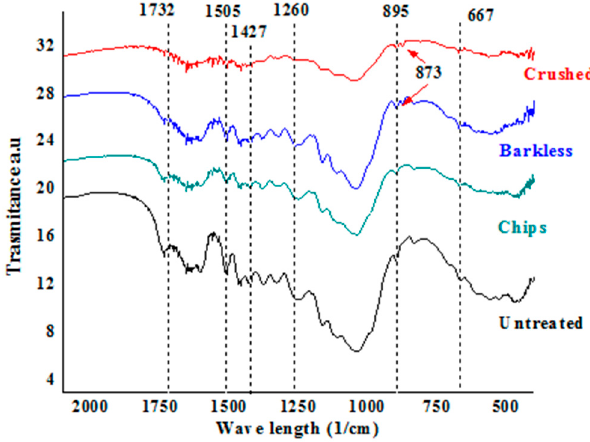
Figure 8. Fourier-transform infrared spectra in the 2100–500 cm − 1 range of untreated and Ca(OH) 2 -treated G. angustifolia samples.